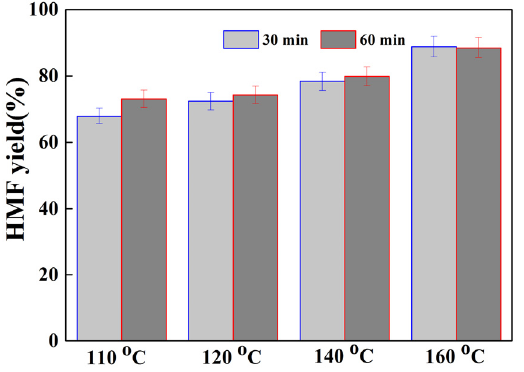
Figure 8. HMF yield as a function of reaction temperature under the catalysis of Amberlyst 15.